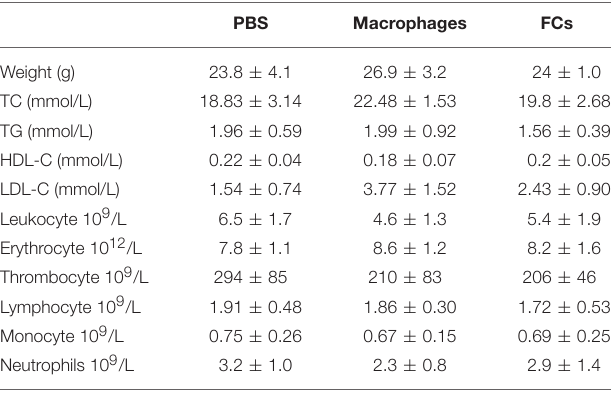
TABLE 1 | The effects of immunization on body weight, plasma lipid profile and blood cells of ApoE − / −